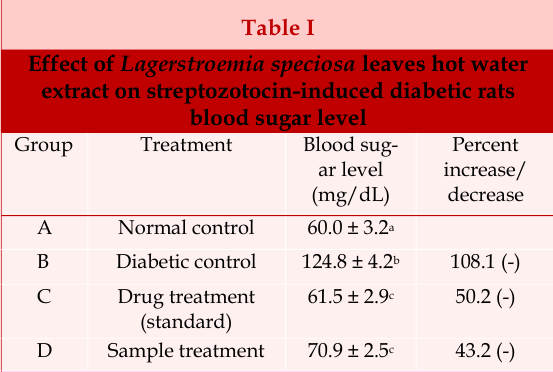
Effect of Lagerstroemia speciosa leaves hot water extract on streptozotocin-induced diabetic rats blood glutathione level